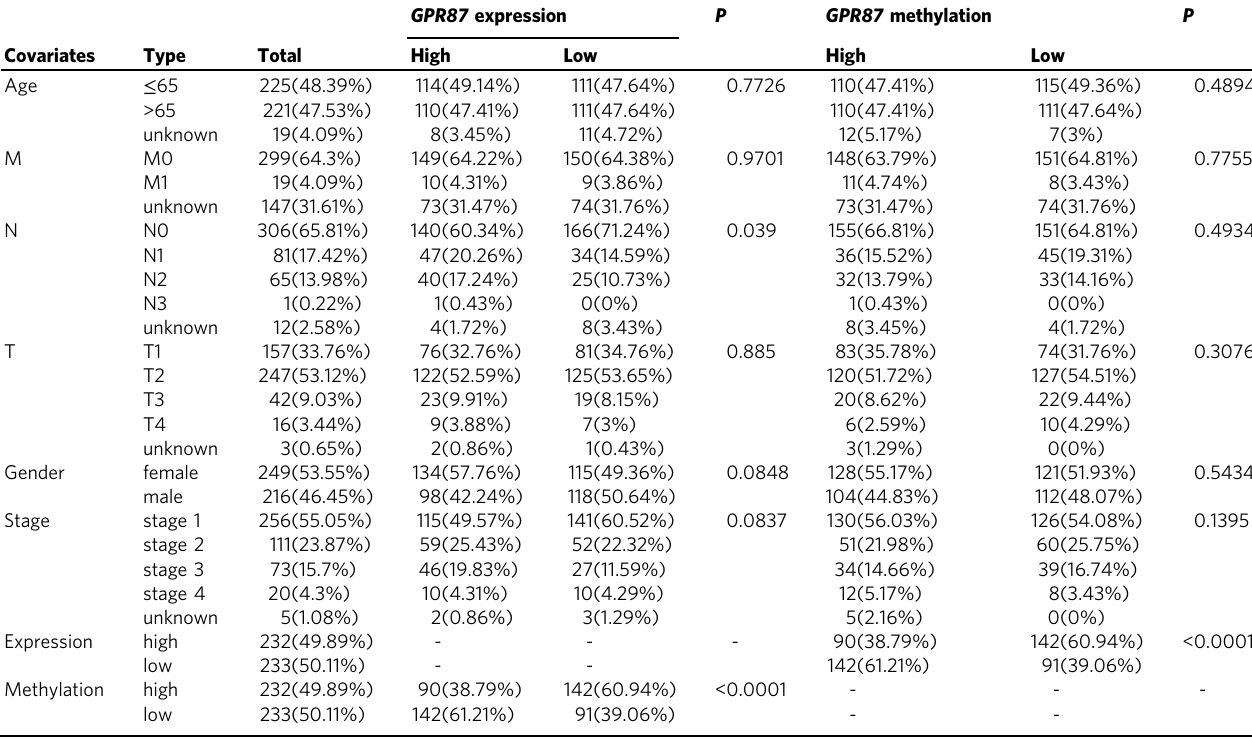
Table 1 Correlation of GPR87 mRNA expression and methylation with clinicopathological features in the TCGA database. GPR87 expression P GPR87